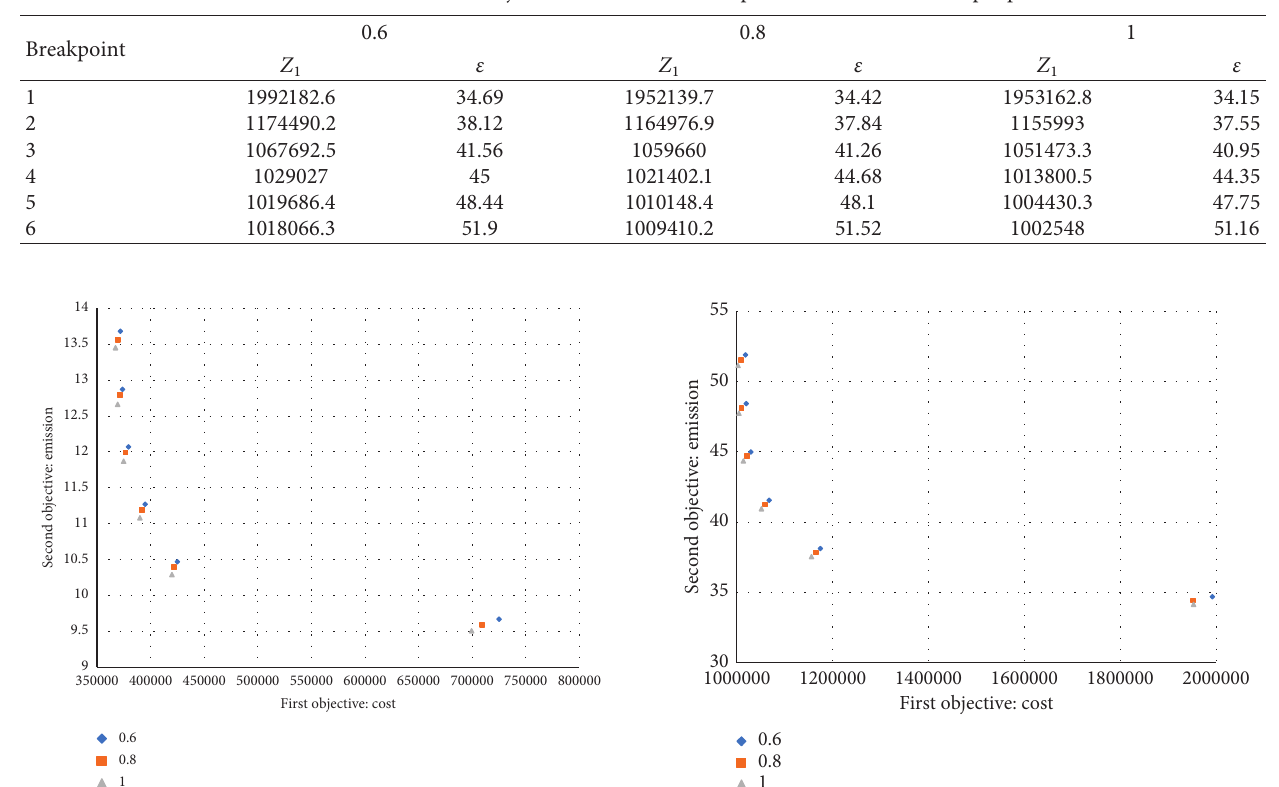
Table 9: The value of the cost objective function for breakpoints of the second sample problem.